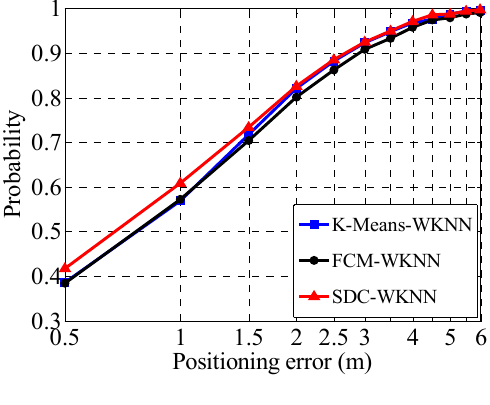
Figure 8. Positioning accuracies based on three different clustering methods.